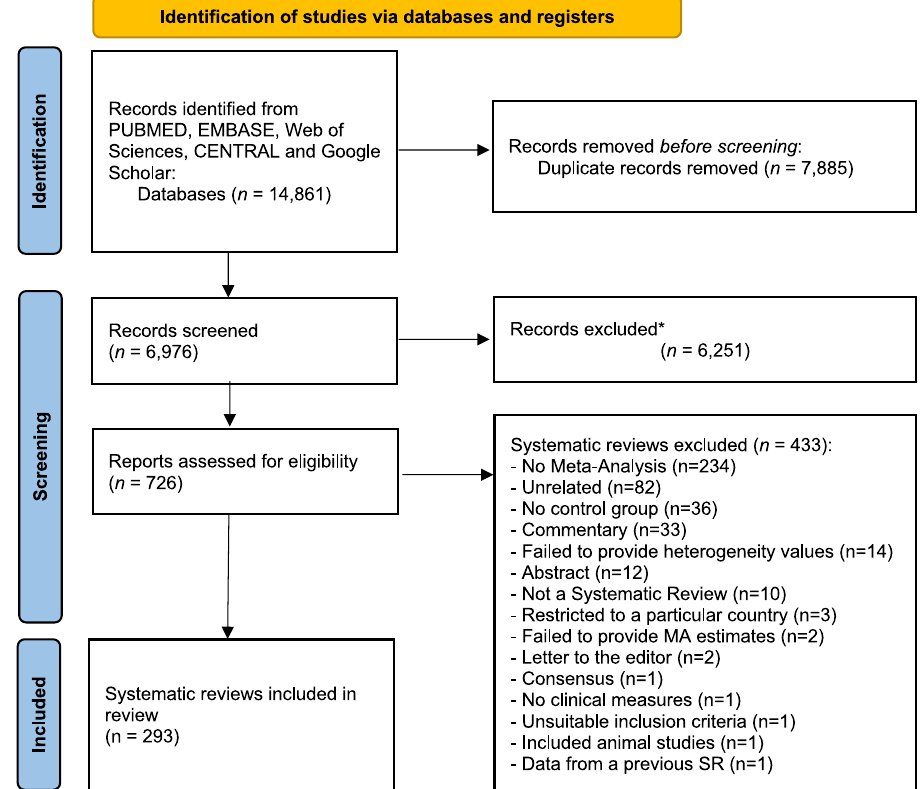
Fig. 1 | PRISMA Flowchart. Flow diagram visually summarising the screening and selection processes, and the numbers of articles recorded at each different